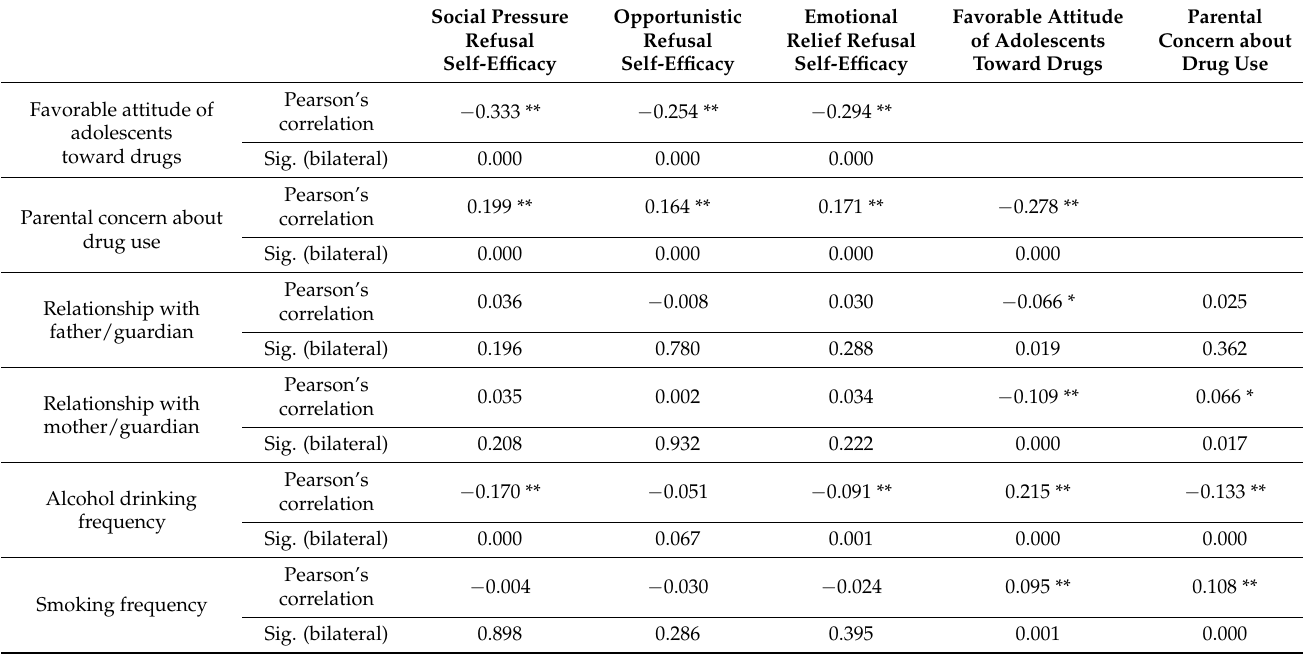
Table 2. Correlation analysis of variables. Pearson’s correlations ( N =